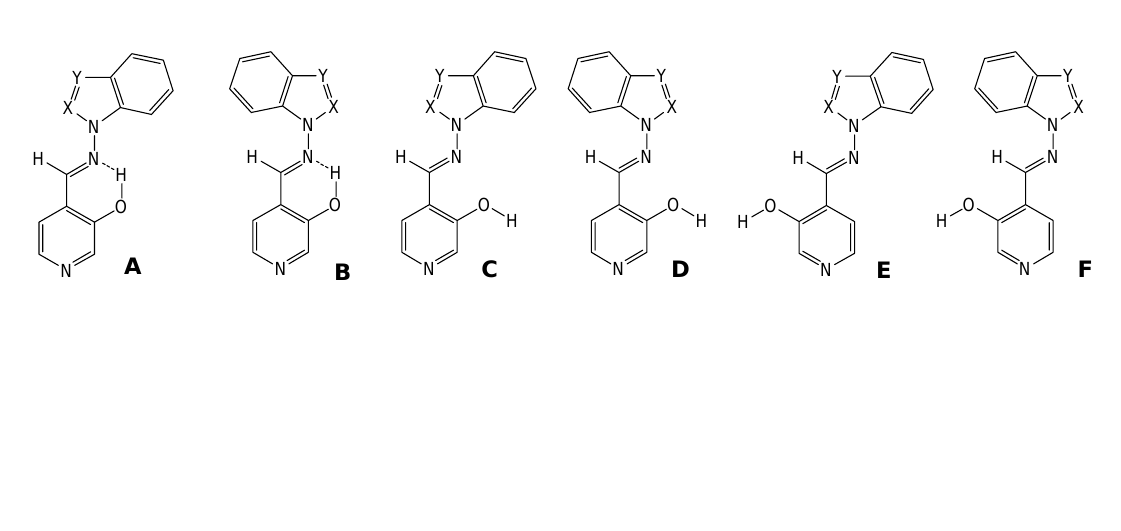
Figure 1. Calculated conformations A - F for ( E )-4-[1 H -benzazol-1-ylimino)methyl]- pyridin-3-ols ( 7a , X=CH, Y=N; 7b , X=N, Y=CH; 7d ,